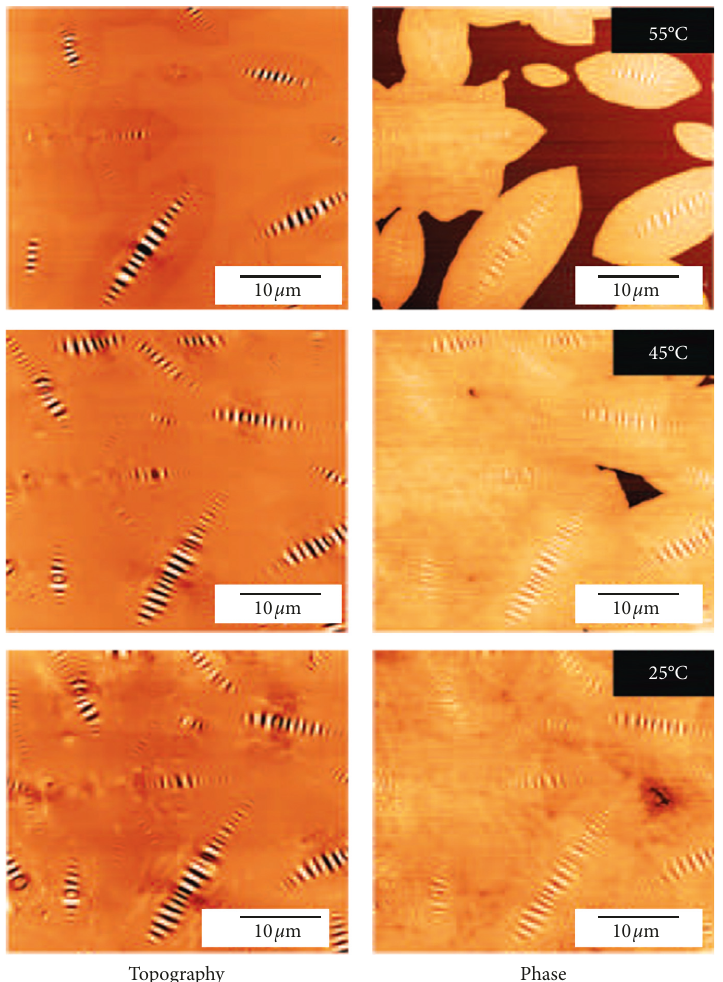
Figure 9: Microscopic images of asphalt morphologies under different temperatures. The figure is obtained from Nahar [31] (under the creative commons attribution license/public